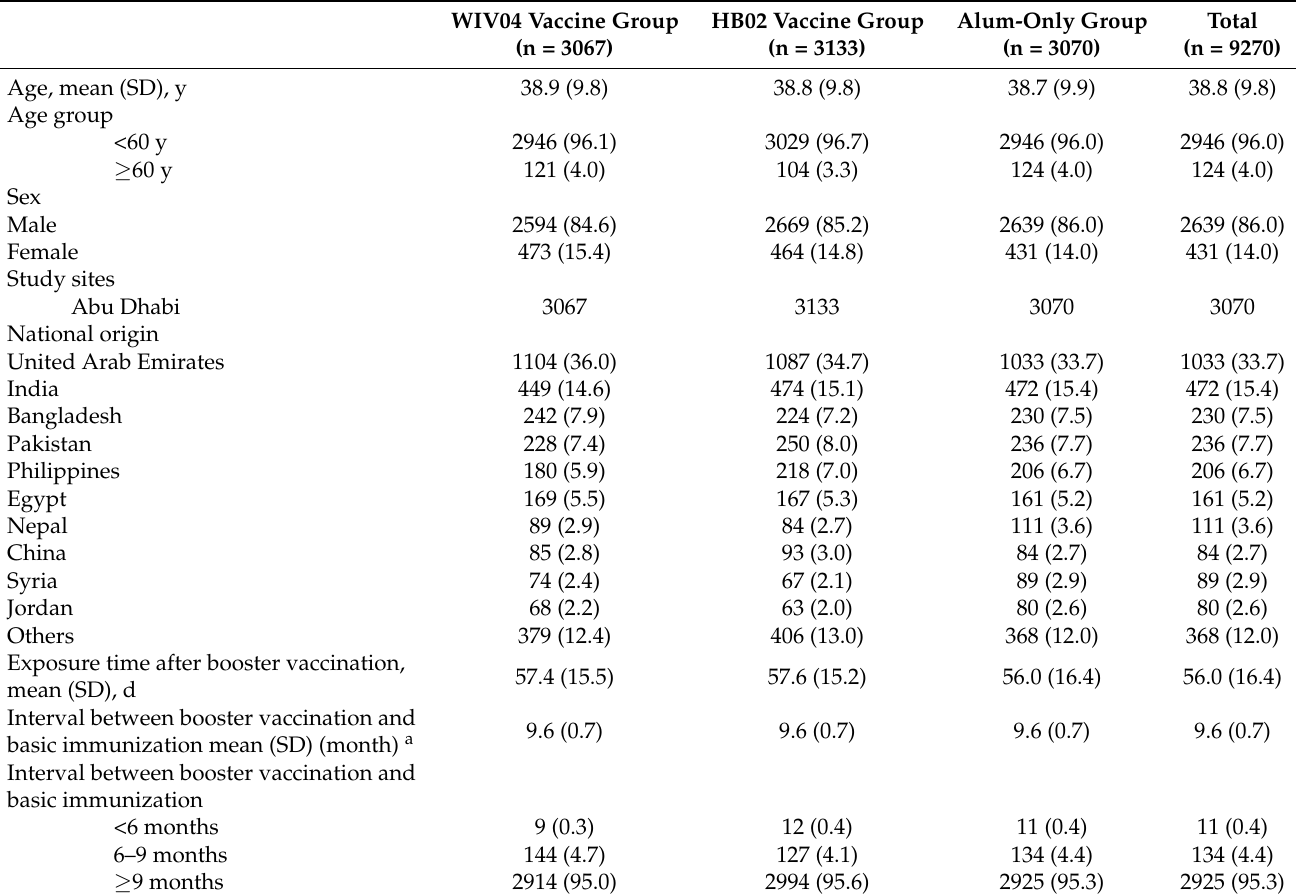
Table 1. Baseline Characteristics of